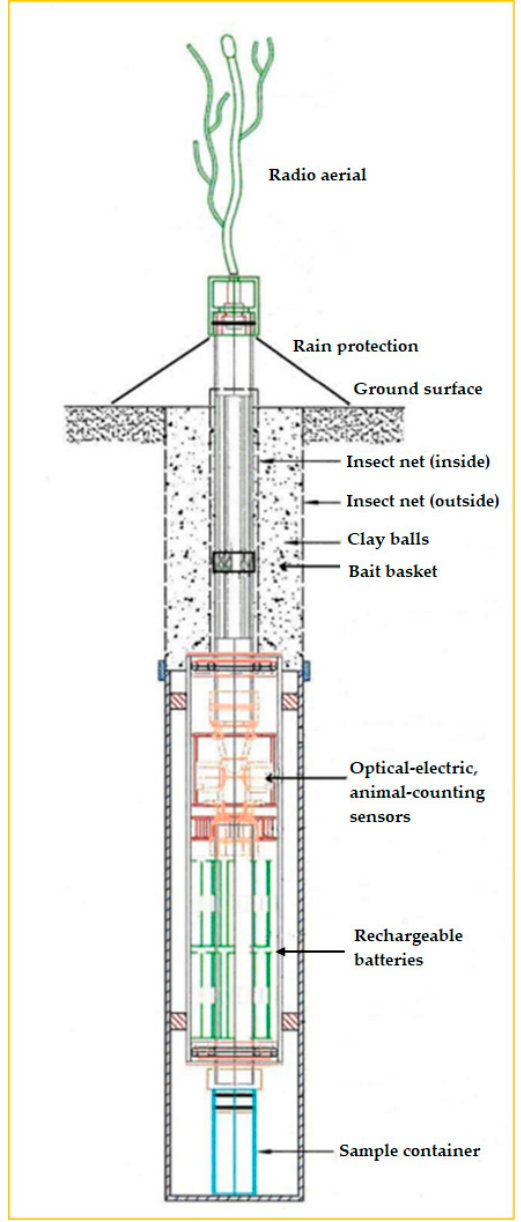
Figure 1. EDAPHOLOG probe provides the house for the opto-electronic sensors. It is part of a new soil environmental monitoring tool, called EDAPHOLOG System. EDAPHOLOG System